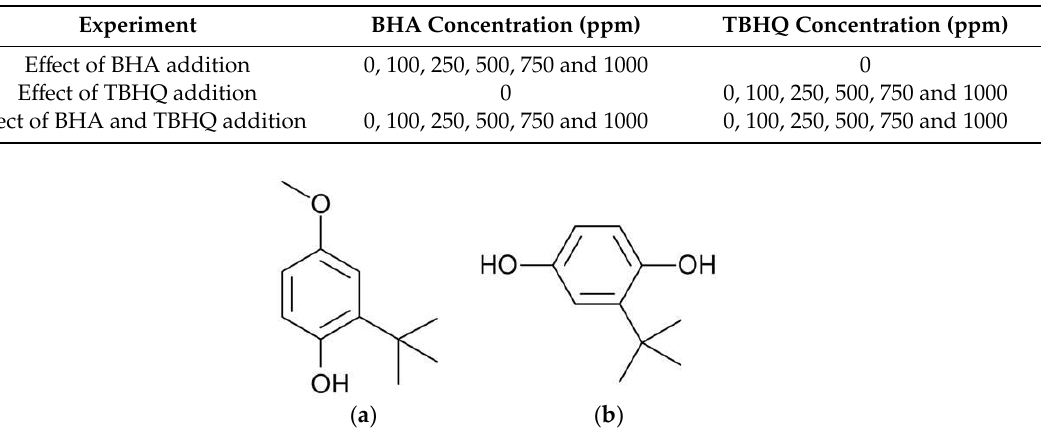
Figure1. Molecularstructureof( a )butylatedhydroxyanisole(BHA)and( b )tert-butylhydroquinone(TBHQ). Figure 1. Molecular structure of ( a ) butylated hydroxyanisole (BHA) and ( b ) tert-butylhydroquinone (TBHQ).